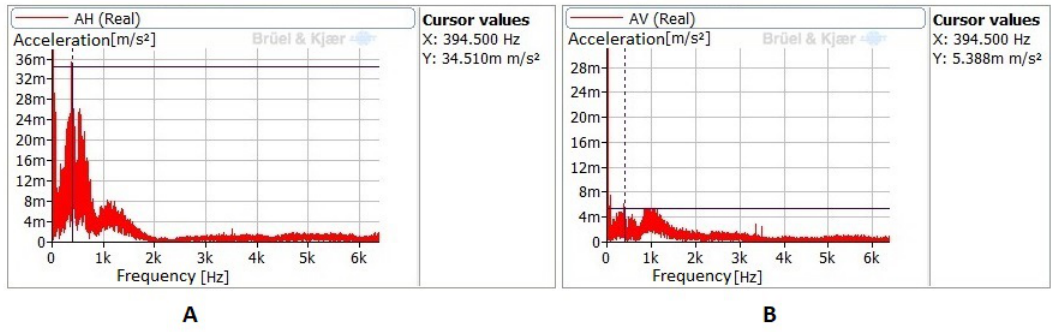
Figure 10. UVABB tool excitation signals measured on the longitudinal and radial directions. 900 mm/min, 400 N, 1 pass, vibrations OFF. ( A ) AH sensor; ( B ) AV